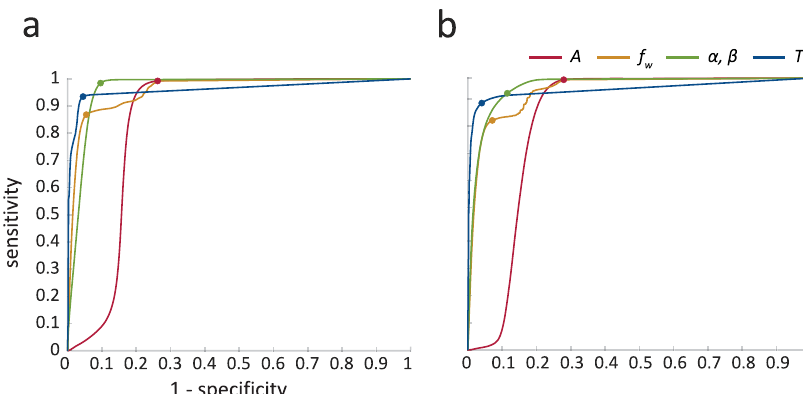
Fig. 5 Tuning parameter selection. Receiver-operating characteristics (ROC) used for tuning parameter selection using one vs. all approach (normal walking vs. all non-walking activities). ROCs were computed separately for sensor body locations common to the smartphone ( a ) and smartwatch ( b ). Dots represent optimal cutoff points at which the sum of sensitivity and speci fi city is